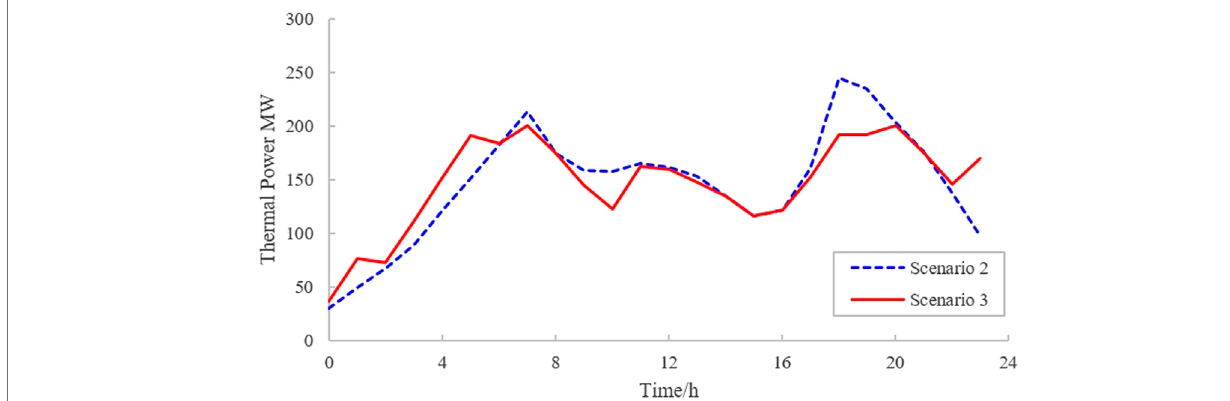
FIGURE 8 | Comparison of thermal power output curves.